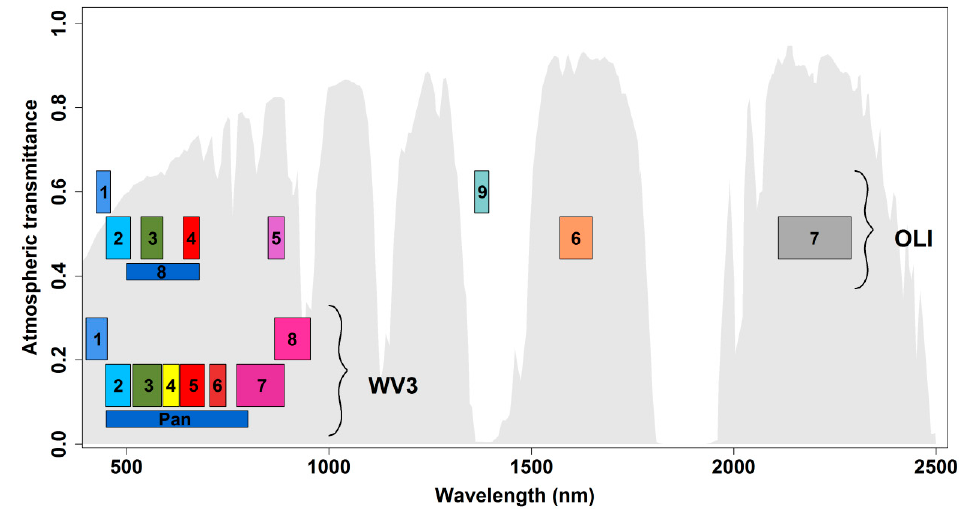
Figure 1. Operational Land Imager (OLI) and WorldView-3 (WV3) spectral band widths represented within the electromagnetic spectrum and locations with higher atmospheric transmittance (grey). Each sensor is designed to reduce impacts from atmospheric absorption by O 3 , H 2 O, CO 2 in the longer wavelengths, and scattering in the shorter wavelengths, typically between 400 nm and 700 nm. OLI band 9 (1360 nm to 1390 nm) is intended to detect high altitude cloud contamination less visible in other spectral bands.